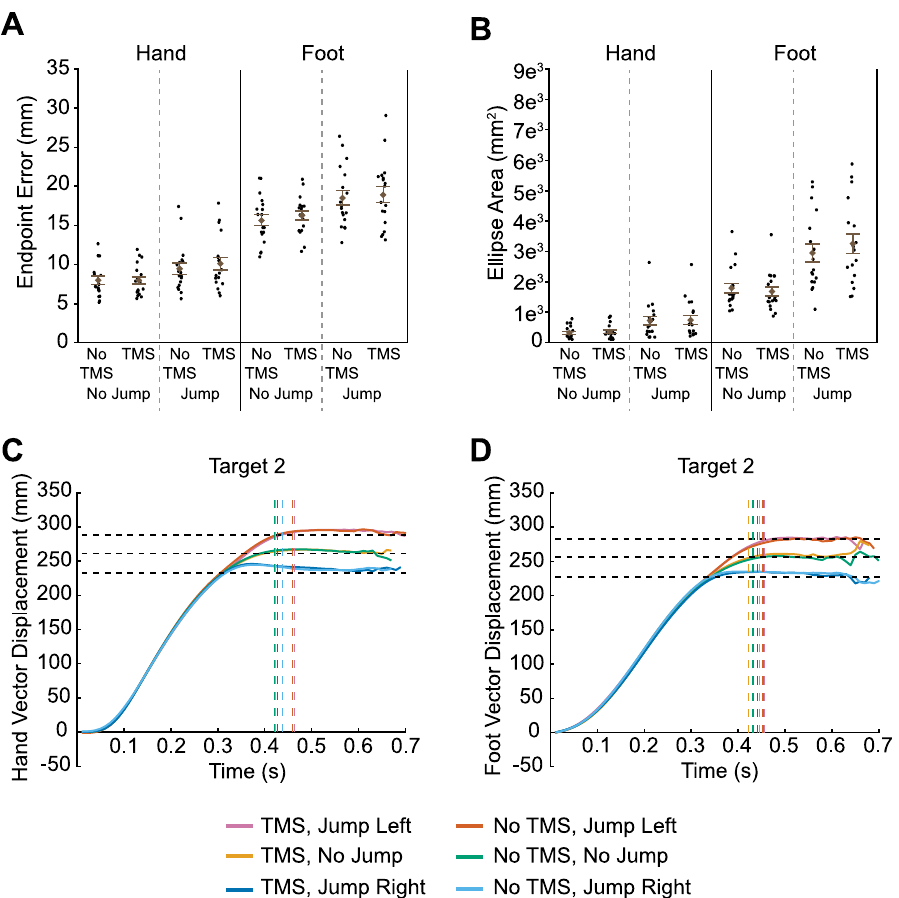
Fig 3. Results of transcranial magnetic stimulation (TMS) to IPS2. Euclidean endpoint error (A) and ellipse area based on endpoint error (B) for hand and foot reaches across all conditions. Filled circles represent mean data from each individual participant. Group mean ± SE is also shown. Hand (C) and foot (D) trajectories towards target two are shown for each condition. Horizontal dashed lines represent the final position of the target (jump left, no jump, and jump right). Vertical dashed lines indicate the average time at which the finger or toe contacted the touchscreen for each condition.